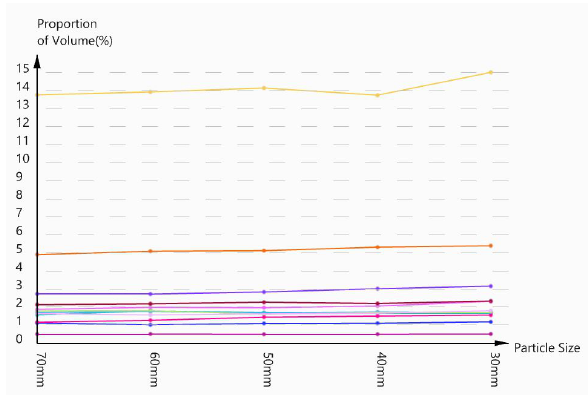
Figure 9. Particle size Testing Result For Test Site 1